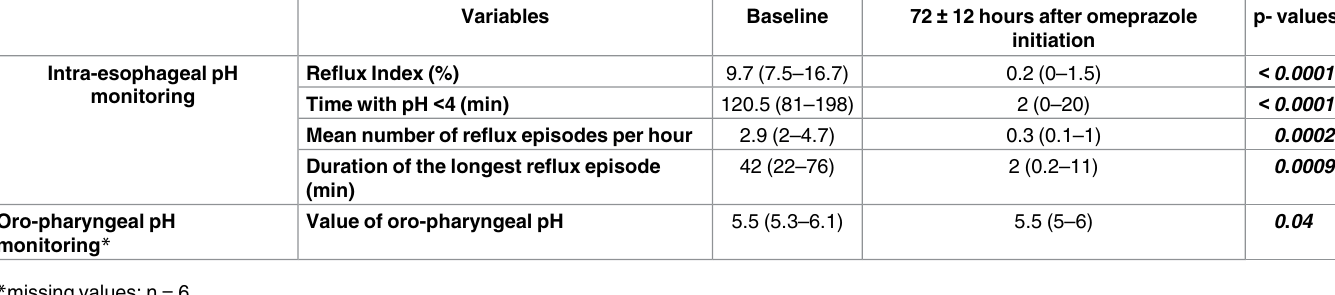
Table 2. Efficacy parameters at baseline and 72 ( ± 12)hours after omeprazole initiation.